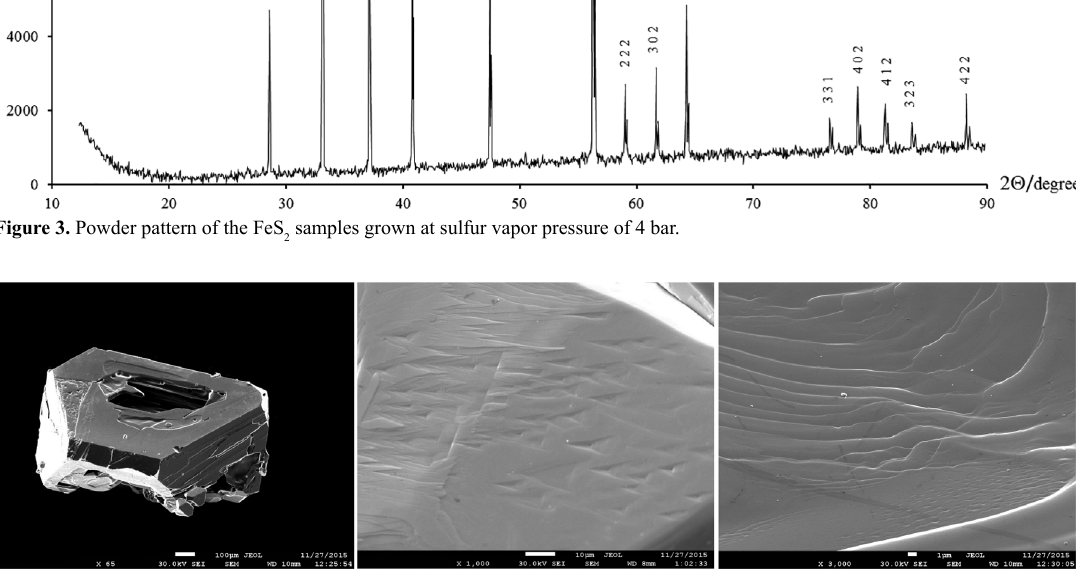
Figure 4. Surface images for the pyrite single crystals, grown by the iron sulfide recrystallization from FeBr vapor: P = 1 bar, (a, b) and P = 10 bar tot.(S x ) tot.(S x )